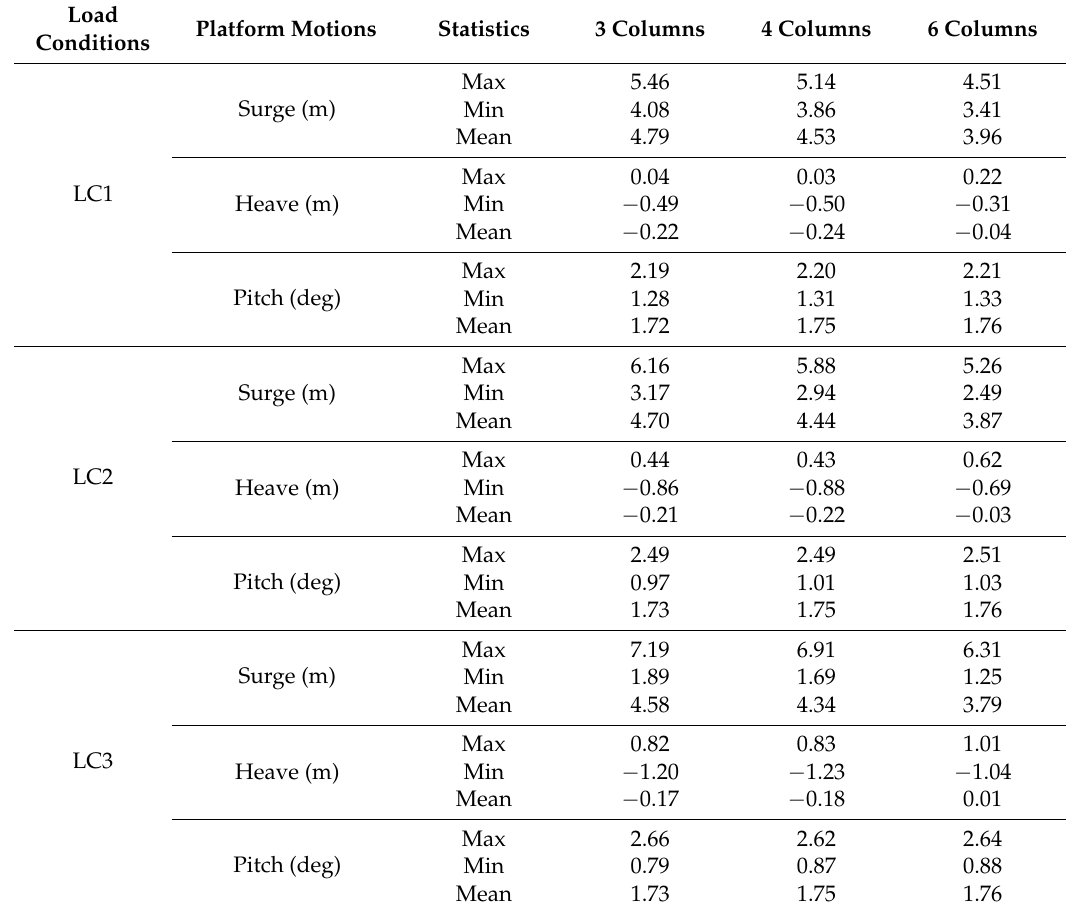
Table 5. Statistics of the motions of the platform in the time domain for